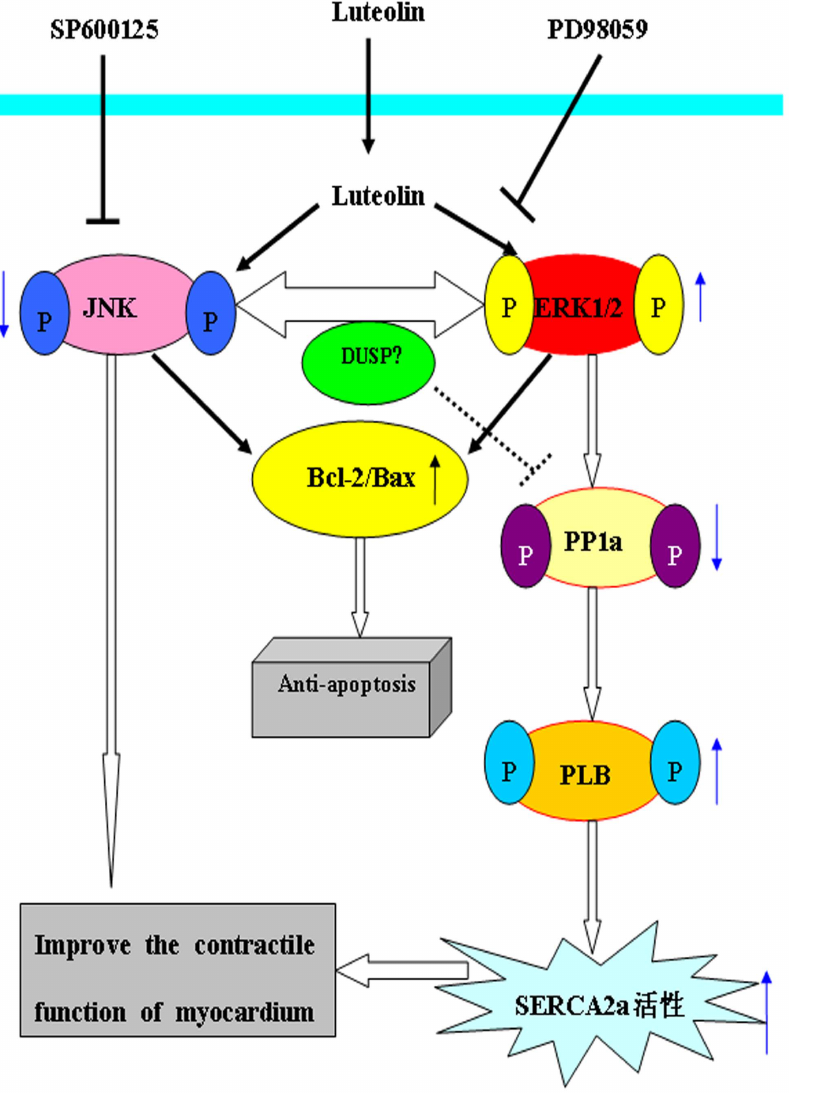
Figure 7. The possible mechanisms of luteolin exerting its protective effects on myocardium following I/R injury. Pretreatment with luteolin and SP600125 can deregulate the expression of p-JNK, upregulate the expression of p-ERK following I/R, which can result in cells apoptosis were inhibited and contractile function of myocardium was improved. Pretreatment with luteolin can also decrease the expression of SERCA2a via ERK1/2-PP1a-PLB pathway. The effect of luteolin was almost completely abolished by pretreatment PD98059 before it.